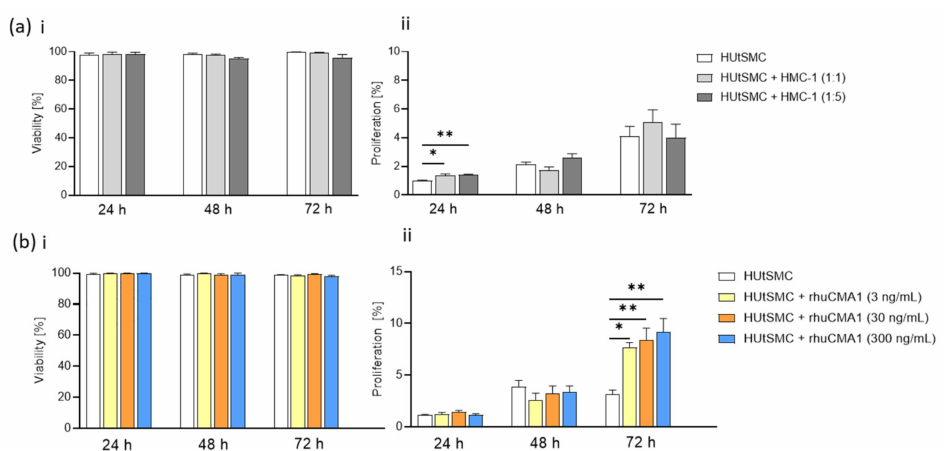
Figure 2. HMC-1 and rhuCMA1 increase HUtSMC proliferation. Viability ( a ( i )) and proliferation ( a ( ii )) of HUtSMC cocultured with HMC-1 cells (HUtSMC: HMC-1 ratio 1:1 and 1:5) at 24/48/72 h. Viability ( b ( i )) and proliferation ( b ( ii )) of HUtSMC cells treated with rhuCMA1 (3 ng/mL, 30 ng/mL, 300 ng/mL) at 24/48/72 h. The results are presented as a mean with SEM. Statistical analysis was performed with the one-way ANOVA or Friedman test (* p < 0.05, ** p < 0.01). HUtSMC: Human uterine vascular smooth-muscle cells; rhuCMA1: recombinant human